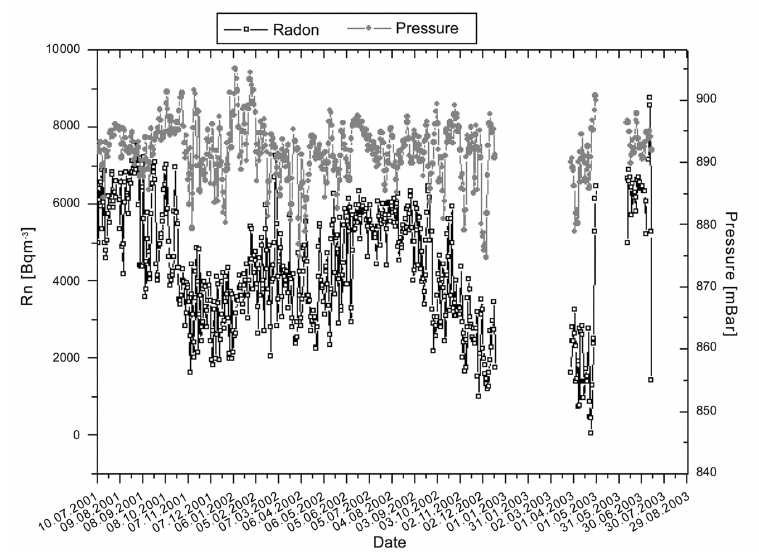
Fig. 2. Daily means of Radon concentration (open square) and of atmospheric pressure (full circle) in the Bian- cavilla site; July 2001-September 2003.